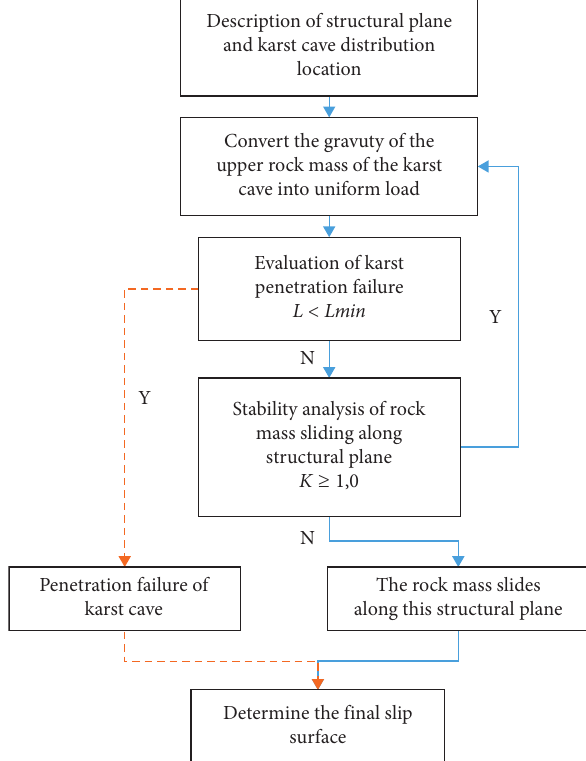
Figure 11: Flowchart for determining the range of the slip surface of a rock foundation pit.